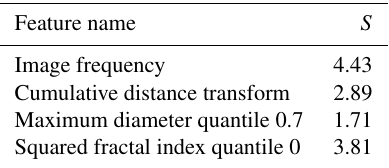
Table 2. Selected features and corresponding S